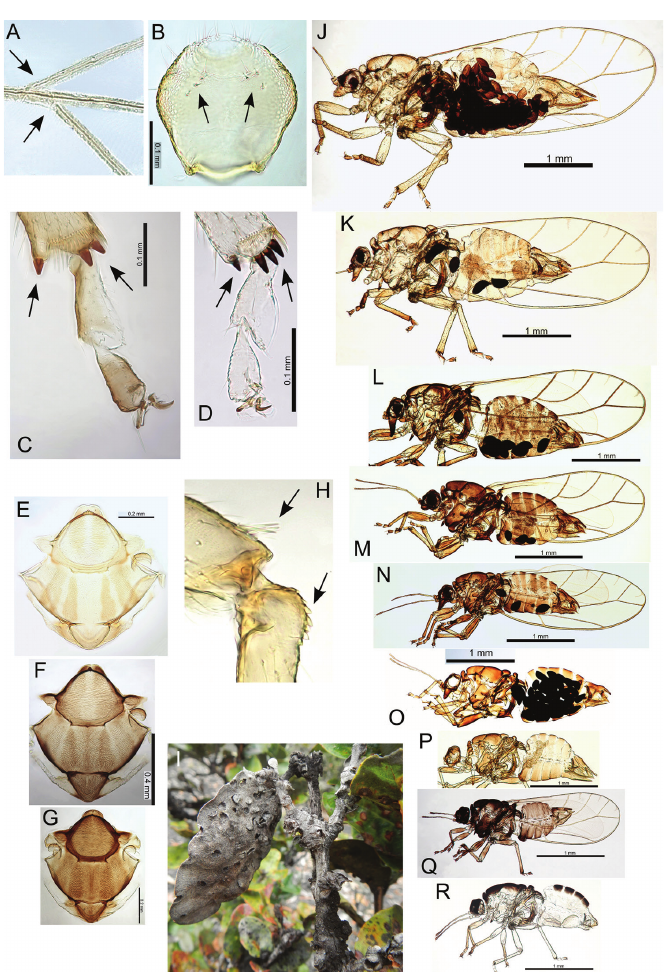
Figure 4. Examples of variability in Pariaconus adults, and an example of severe host damage. A fore wing detail showing a common trait variation with R branching slightly anterior of M and Cu tion ( P. pele ) B posterior surface of male proctiger showing setae on interior of each lobe ( P. pyramidalis ) C typical 1+2 arrangement of sclerotized apical metatibia spurs, the single spur typically more stalked in ohialoha group ( P. molokaiensis ) D common variation of 1+3 arrangement of sclerotized apical metatibia spurs, the single spur typically less stalked in bicoloratus group ( P. namaka ) E-G thorax (dorsal view): E P. hawaiiensis F P. ohiacola G P. dorsostriatus H metafemur with several stout setae apically, and basal metatibia with cluster of genual spines ( P. molokaiensis ) I example of severe damage to a host plant with local necrosis caused by two closed gallers: P. pele (galls on leaf) and P. hawaiiensis (galls on stem and peti- ole) (Kona Hema, Hawaii) J–R adult size variation (females): J–O ohialoha group (abdomens with dark coloured eggs), P kamua group, Q minutus group, R bicoloratus group, J P. oahuensis (enclosed galls on stem/bud/leaf cones) K P. hawaiiensis (enclosed galls on stem/bud) L P. mauiensis (unknown gall biology) M P. montgomeri (enclosed flat gall on leaf) N P. ohiacola (enclosed flat gall on leaf) O P. pele (enclosed flat gall on leaf) P P. caulicalix (open cup gall on stem) Q P. gibbosus (unconfirmed, likely open pit gall on leaf) R P. hina (abdomen with pale eggs) (unconfirmed, likely